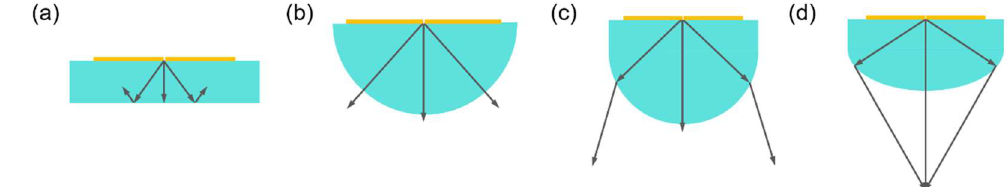
Figure 1. Antenna with ( a ) no substrate lens, ( b ) hemispherical lens, ( c ) hyper-hemisphere lens and ( d ) elliptical lens.